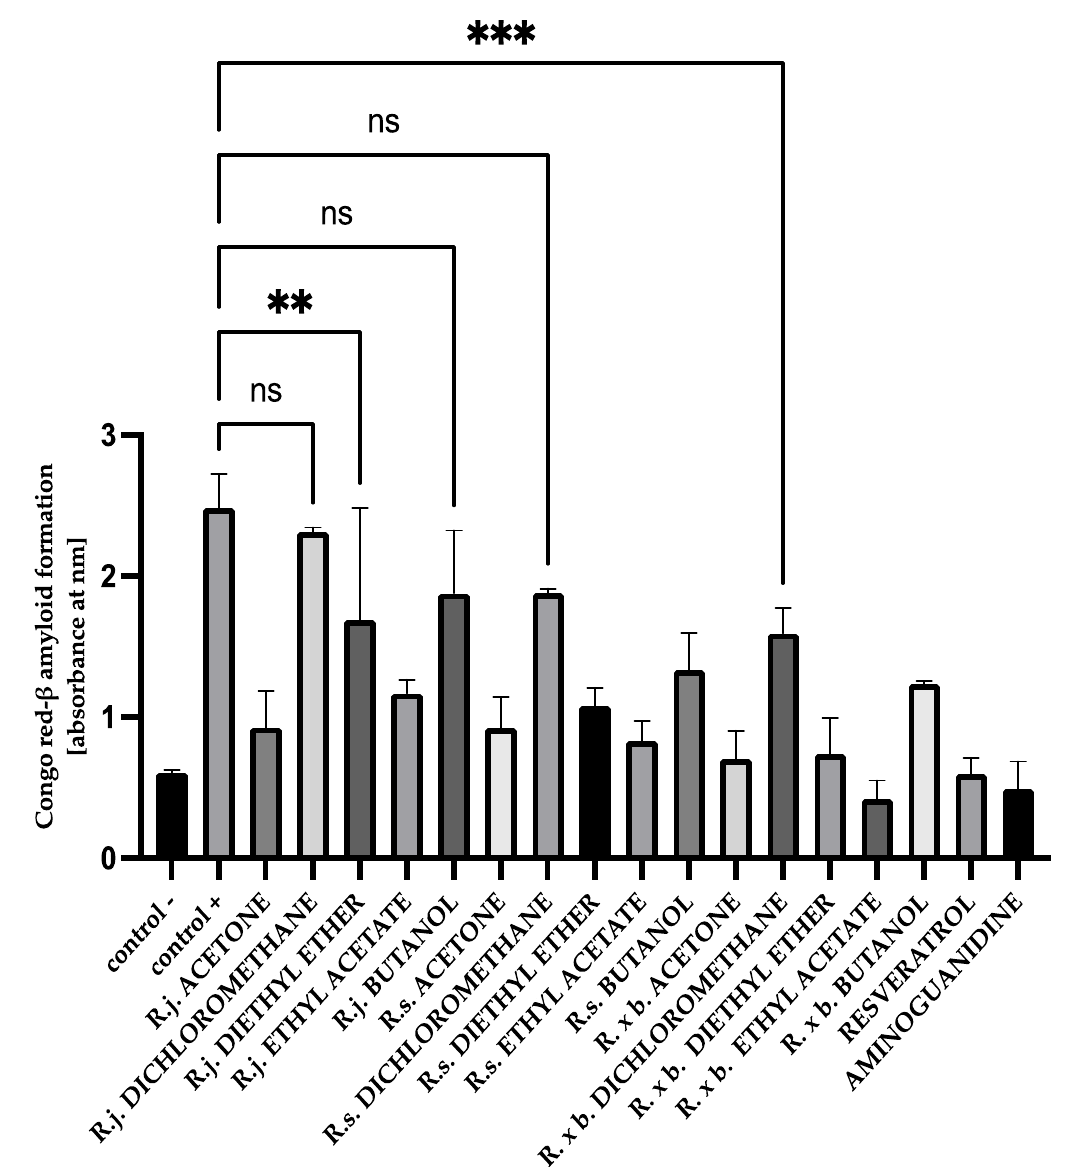
Figure 13. The effect of extracts and fractions on the in vitro formation of amyloid- β products—Congo red in HSA glycation. R.j., R.s., and R. × b. mean Reynoutria japonica , Reynoutria sachalinensis , and Reynoutria × bohemica , respectively. Error bars shown in this figure are means ± SD for n ≥ 5. *** Statistically significant at p ≤ 0.001 compared to control, ** Statistically significant at p ≤ 0.01 compared to control; ns—not statistically significant at p ≤ 0.05. All other results are statistically significant at p ≤ 0.0001 compared to control +. Detailed information can be found in the Supplementary Material.